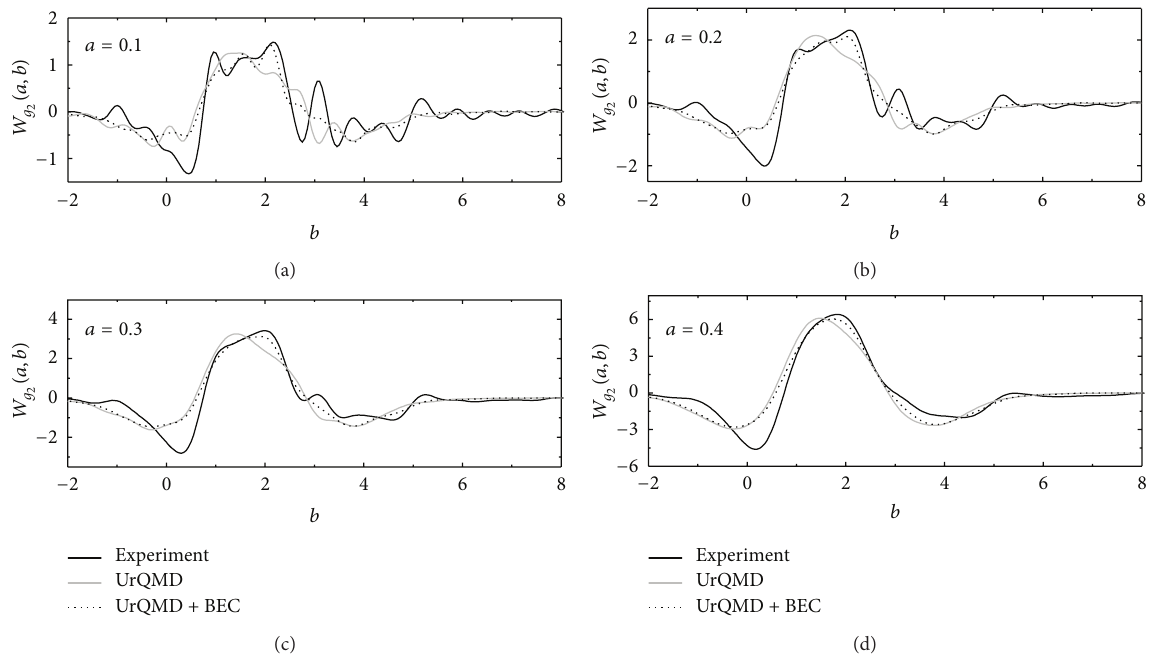
Figure 2: 𝑔 2 wavelet pseudorapidity spectra of 28 Si-Ag/Br interaction at 14.5AGeV for different values of the scale parameter 𝑎